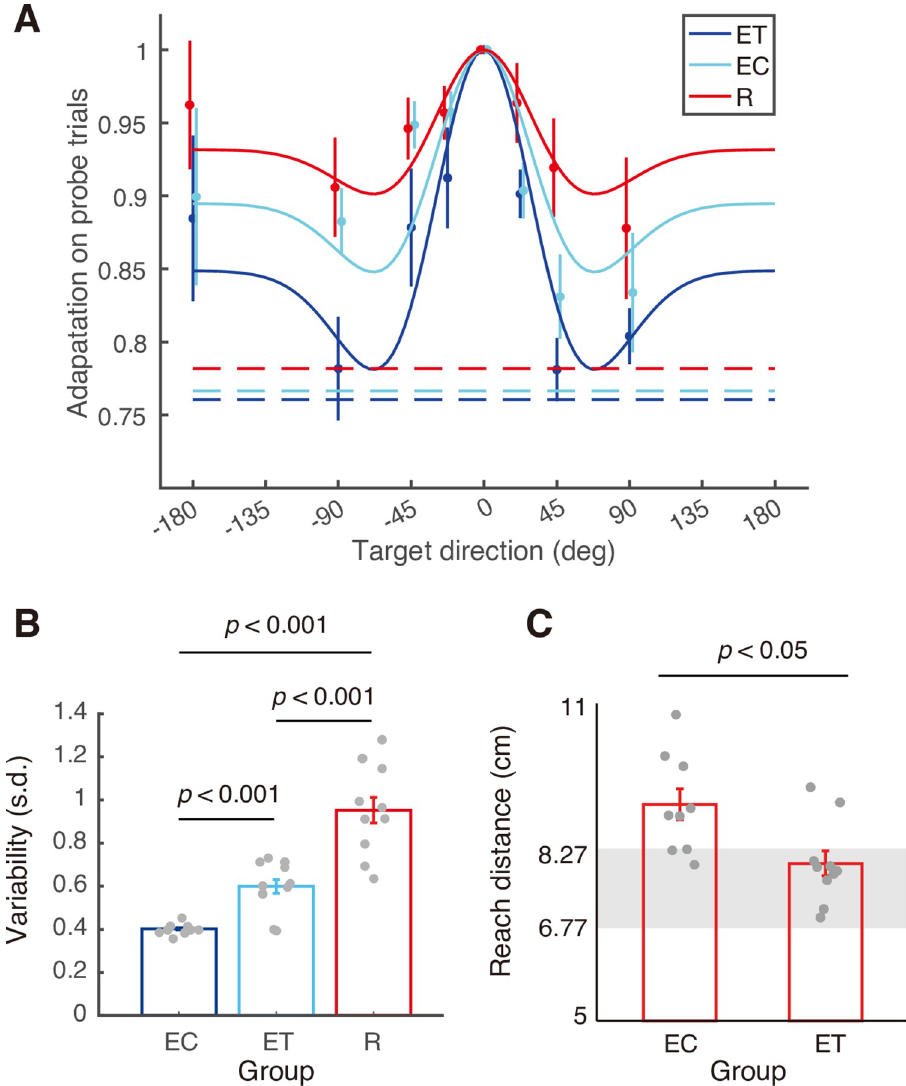
Fig 3. Generalization, variability and retention of adaptation. (A) Generalization on probe (no feedback) trials as a function of target direction. The adaptation for each participant was first averaged across repetitions for the same probe target, and then normalized to the adaptation for probe trials to the training target. Circles and error bars represent means ± SEs across participants. The solid lines show fits of the best fitting Mexican hat generalization functions (fixed width but varying amplitudes). The dashed lines show the level of adaptation corresponding to no generalization of the gain change. (B) Variability computed as the standard deviation of the reach distance of all training trials in the generalization and post-generalization phases where the cursor to hand movement gain was 1.33. Bars show mean ± SEs across participants. Dots show individual participants. (C) Hand reach distance in the second block of 15 trials in the transfer phase with reinforcement feedback for the EC and ET groups. Grey zones show the hand target region, which was constant (2 cm target diameter) in cursor coordinates. Bars and dots as in